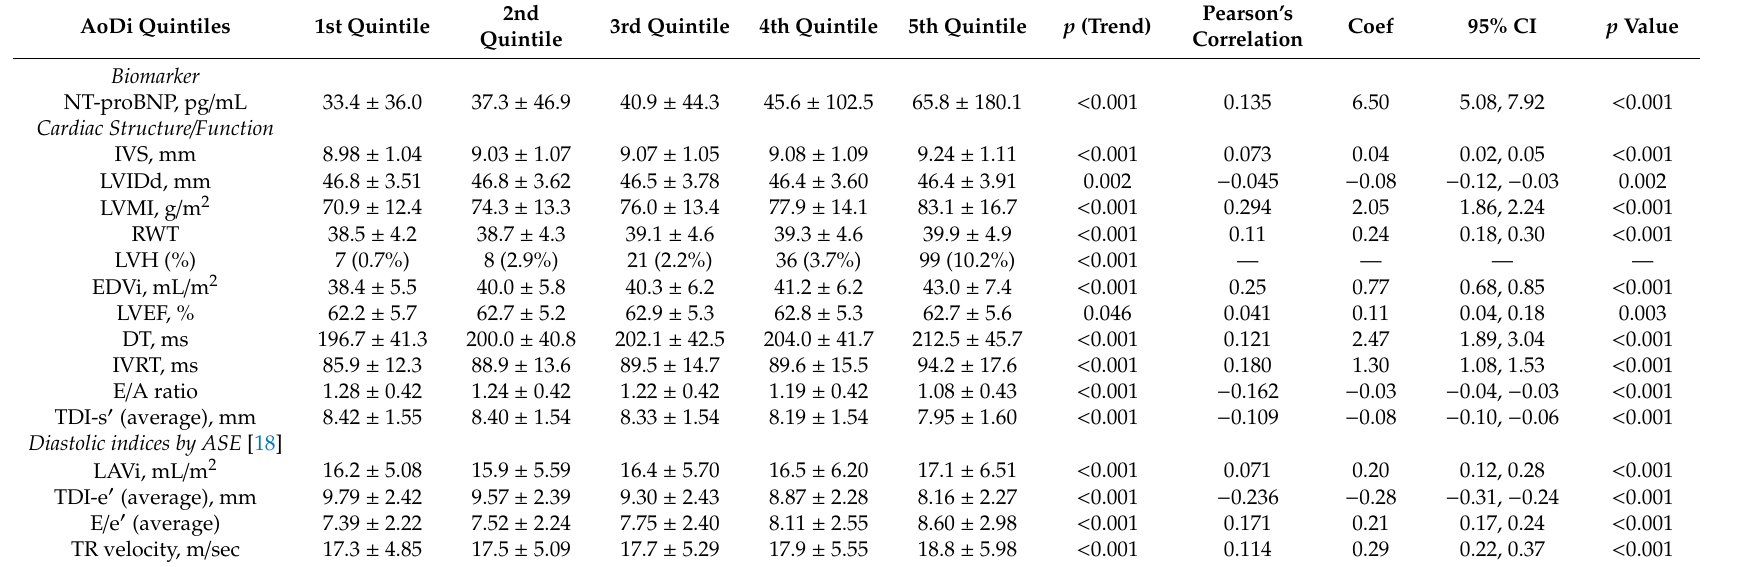
Table 2. NT-proBNP level and echocardiographic parameters stratified by indexed aortic root